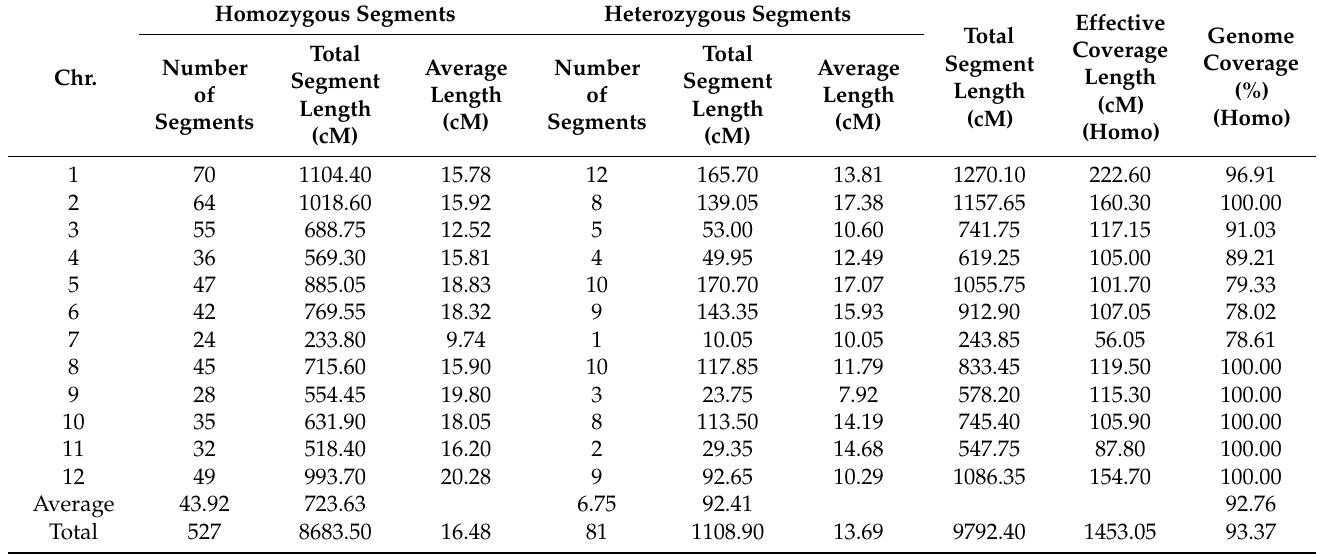
Table 2. Substitution segments of Dongxiang wild rice in a chromosome segment substitution line population, and the cumulative proportion of donor genome represented by homozygous and heterozygous